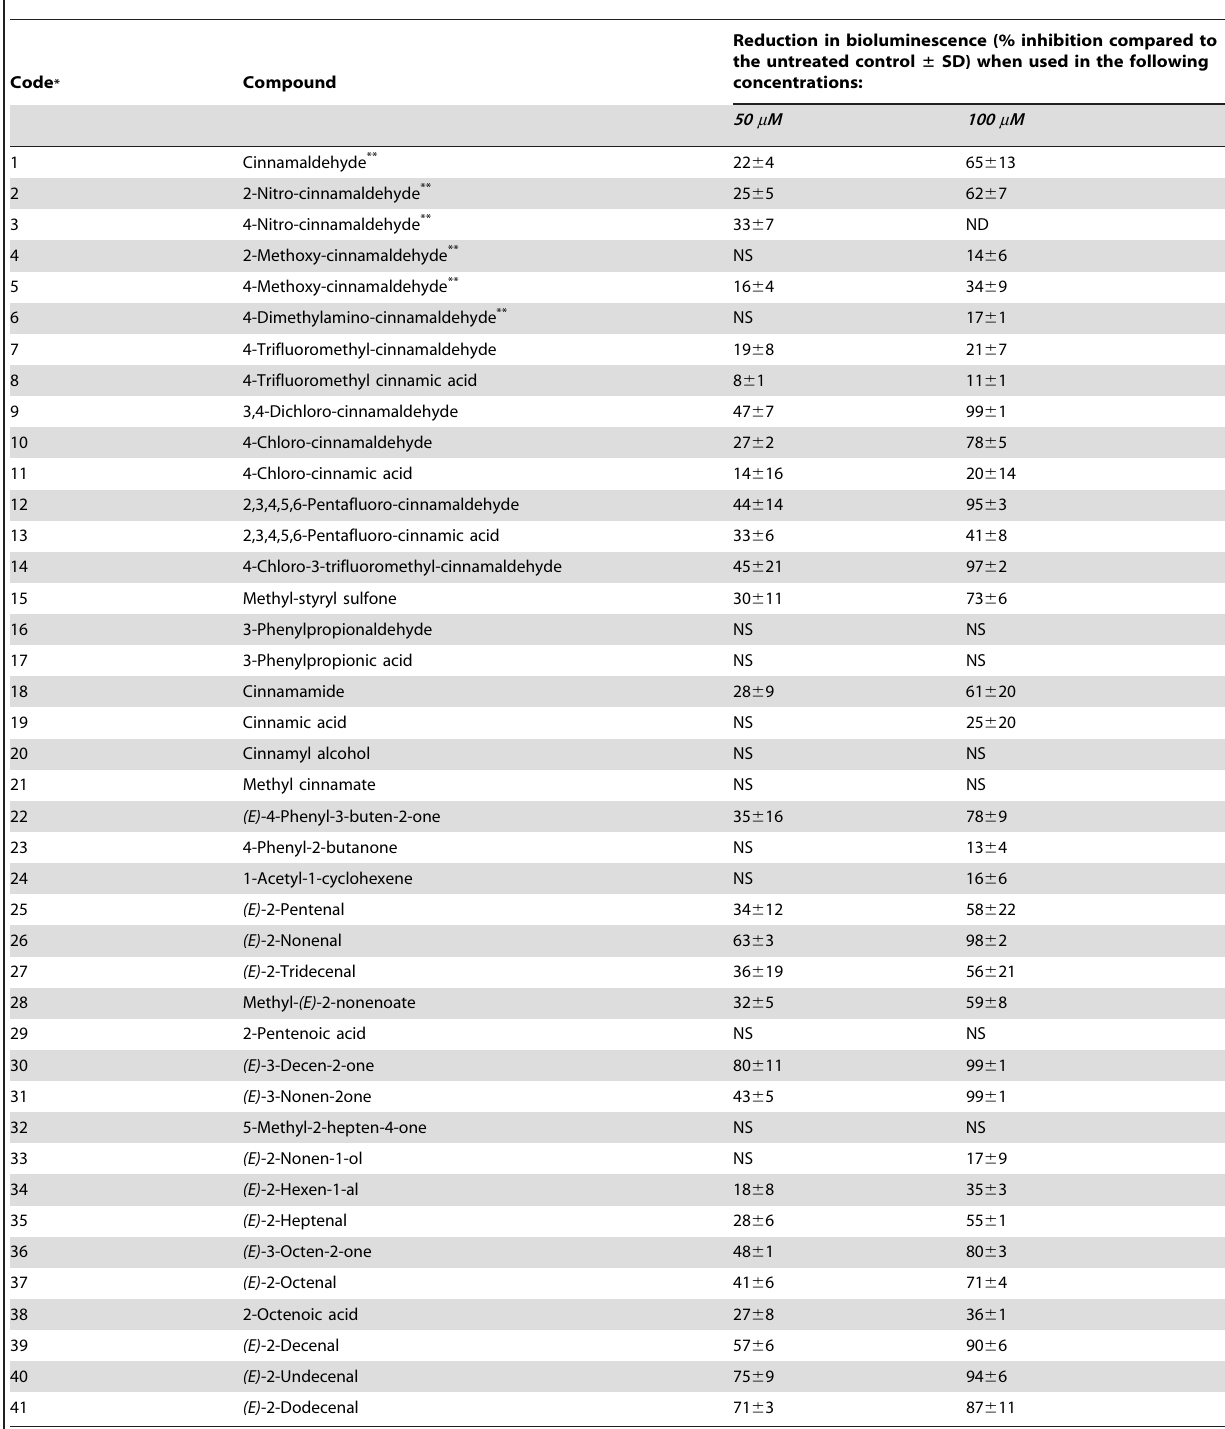
* ;Code refers to structures in Figure 1. ** ; previously assessed for their effect on AI-2 quorum sensing [10]. ND: not determined due to growth inhibition when used at this concentration. NS: compound did not result in a significant inhibition of the bioluminescence signal (p . 0.05; independent sample t-test).